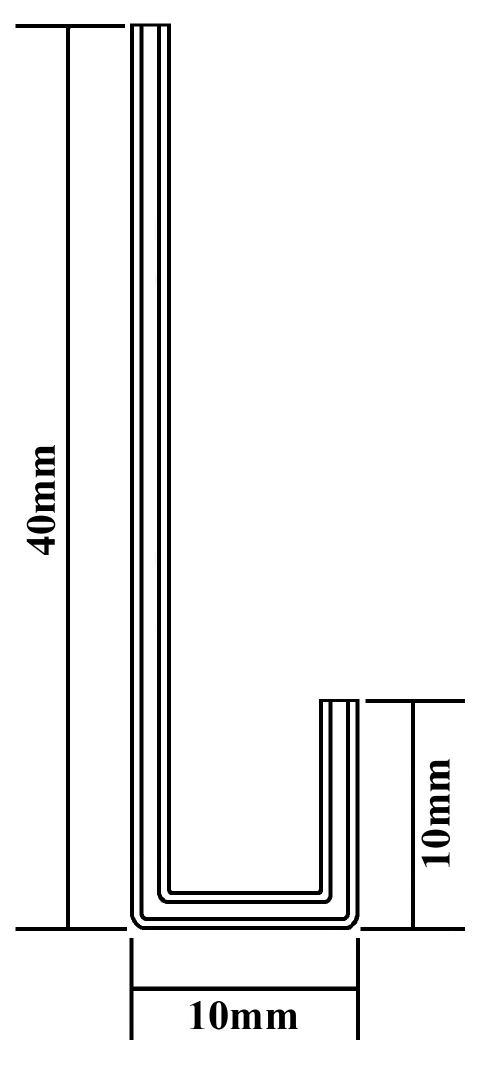
Figure 1. Illustration of microcapillary tube used to estimate lifetime adult